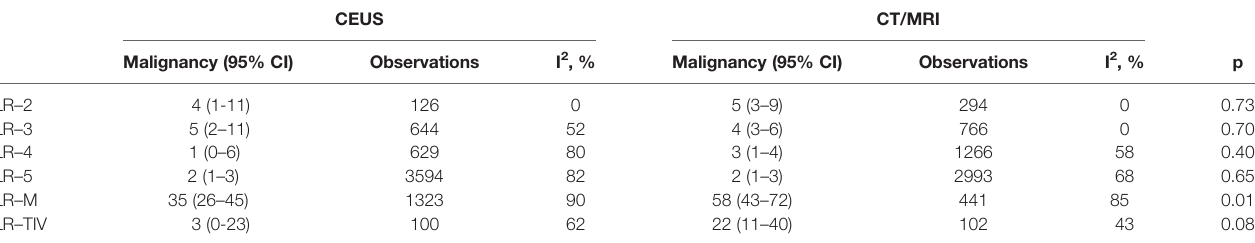
TABLE 2 | Proportions of non-HCC malignancies in each CEUS and CT/MRI LI-RADS category. CEUS CT/MRI Malignancy (95% CI) Observations